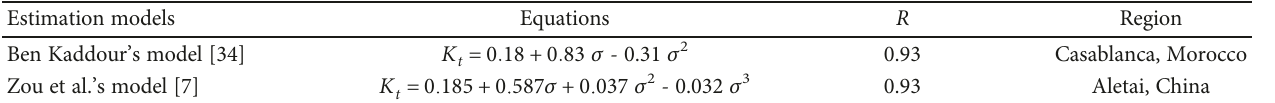
Table 2: Quadratic and cubic models for estimating daily global solar